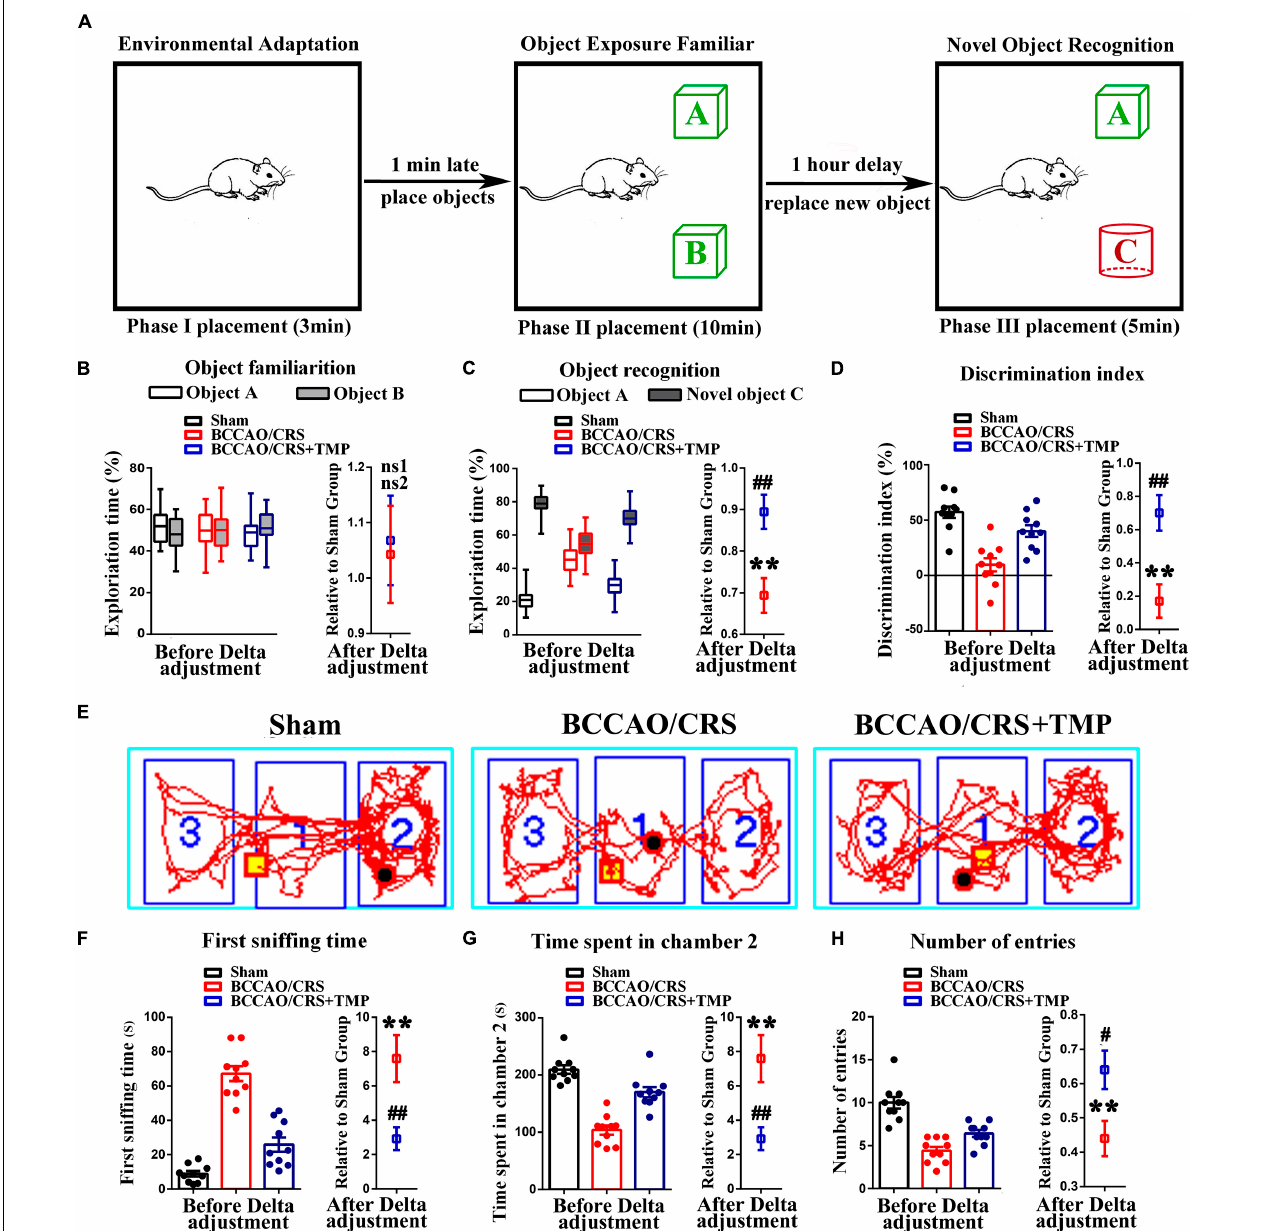
FIGURE 4 | TMP improves recognitive ability and sociability in BCCAO/CRS rats. (A) Diagrammatic sketch of novel object recognition test (NORT). (B) Time of rats spent on exploring two identical object A and B during the period of familiarization. (C) Time of rats spent on exploring old object A or B and novel object C during the period of recognition. (D) Novel object discrimination index of rats during the period of recognition. (E) Representative traces of rats moving in the 3-chamber sociability test. (F) Time that rats exerting first sniffing at additional rats in the social interaction test (SIT). (G) Bargraph indicating the time of social interaction during SIT. (H) Times that rats entered the chamber 2 during SIT. ** P < 0.01, ns1 P > 0.05 vs. Sham. # P < 0.05, ## P < 0.01, ns P > 0.05 vs. BCCAO/CRS. Data are presented as mean ± SE. n = 10 in each